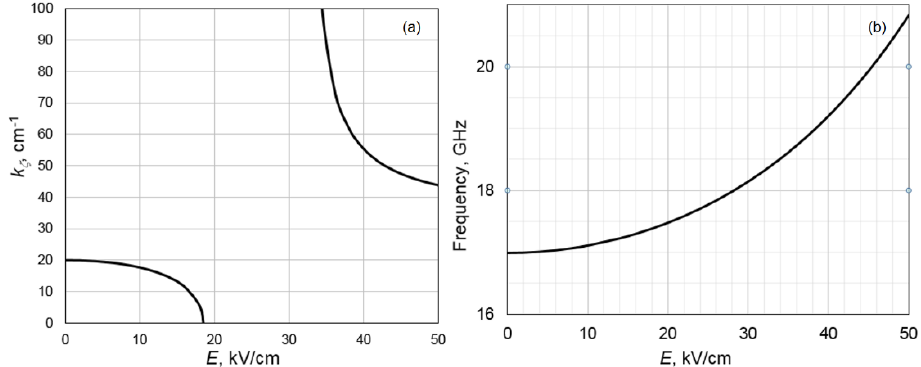
Fig.4. Dependences on the value of constant electric field applied to the PZT layer: (а) for propagation constant of composite structure; (b) for resonance frequency MSA.